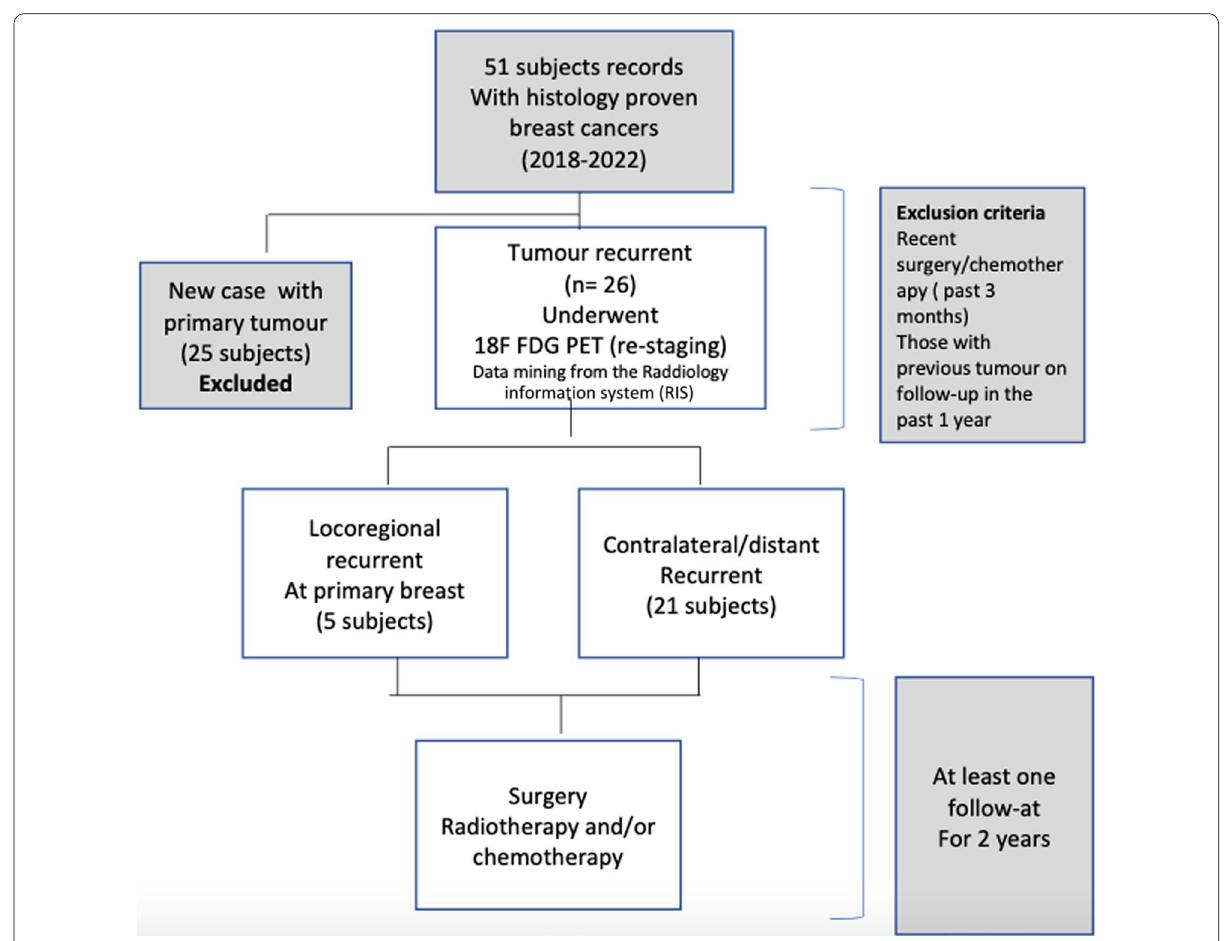
Fig. 1 Data sampling from the Radiology Information System (RIS) and selection process of the 26